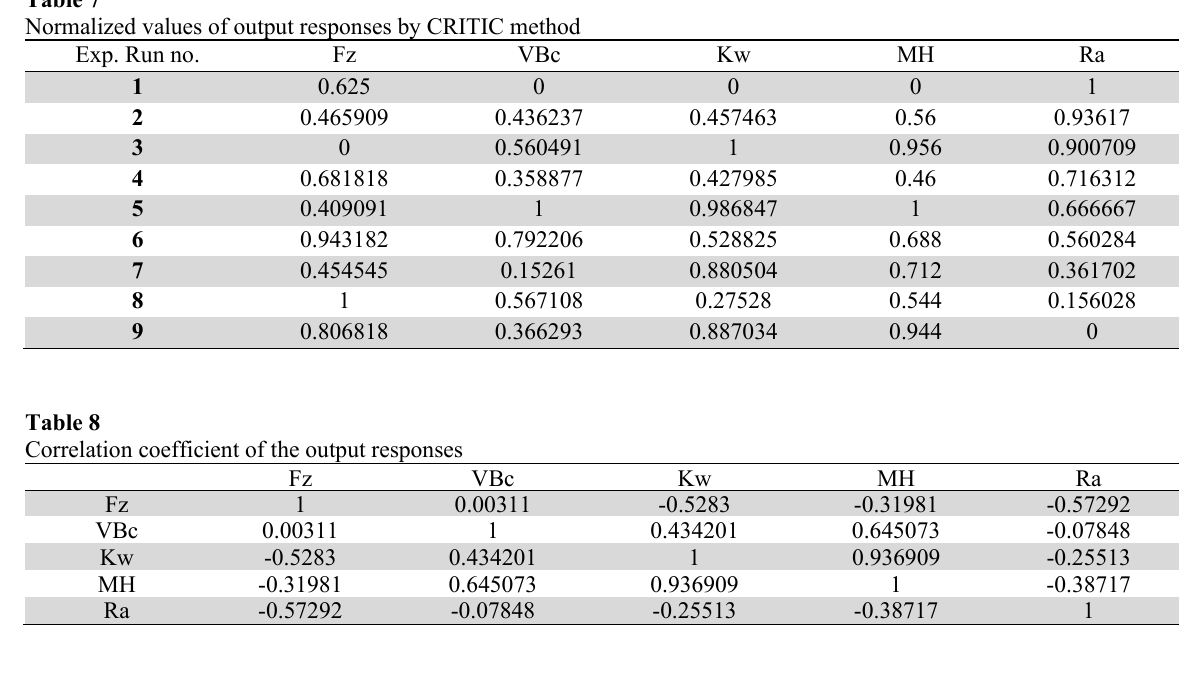
Normalized values of output responses by CRITIC method Exp. Run no.